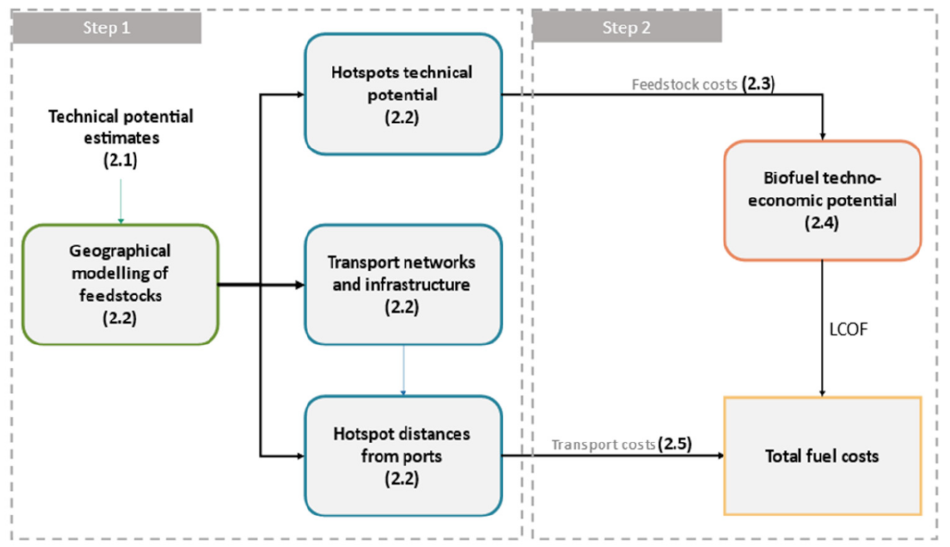
Figure 1. Methodological framework of this study. Numbers in the figure refer to the text sections below for a more elaborate